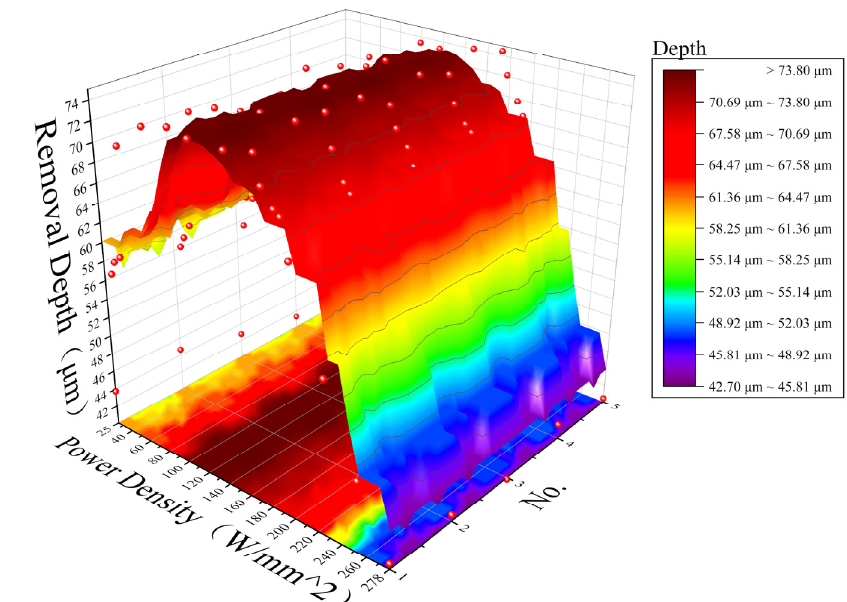
Figure 10. T he removal depth varied with the power density. Figure 10. The removal depth varied with the power